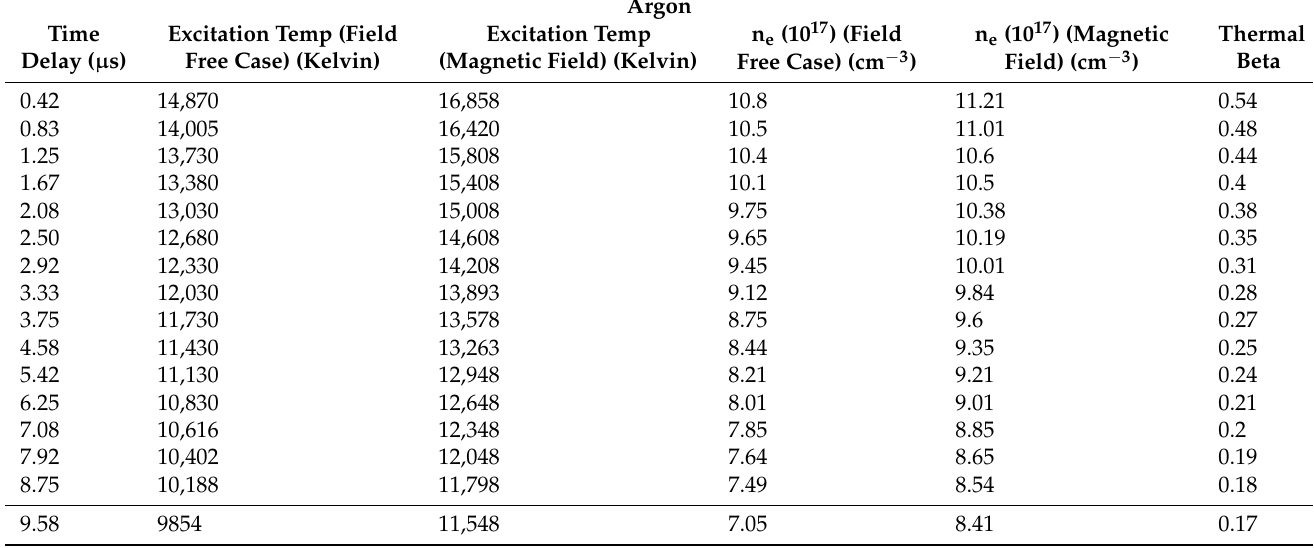
Figure 9. The variation in thermal beta at different time delays. Table 5. Evaluated values of excitation temperature, electron number density, and thermal beta for LPP of Mg under Ar environment at different time delays with and without TMF.